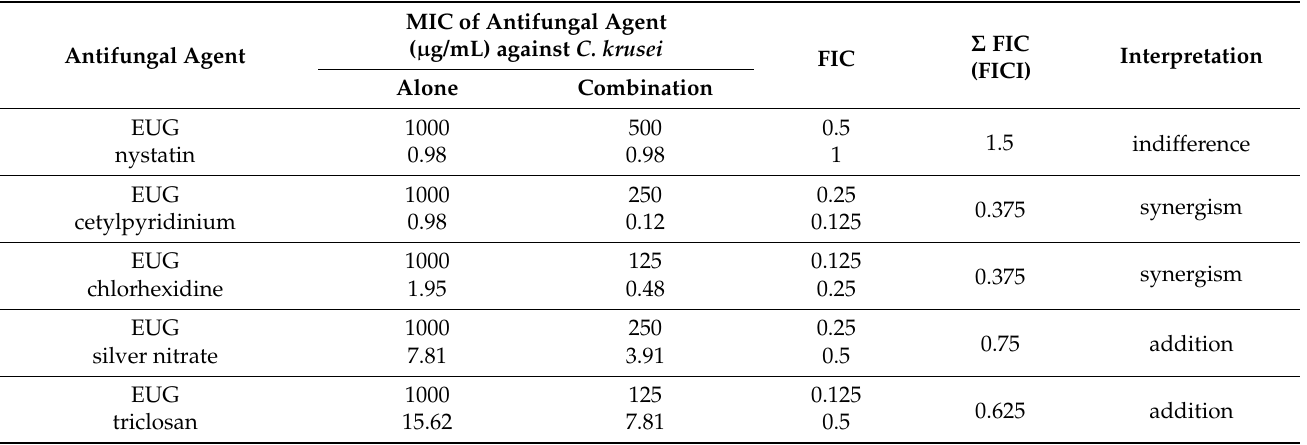
Table 11. MICs and FIC indices of EUG alone and in combination with selected antimycotics on reference C . krusei ATCC 14243 strain.